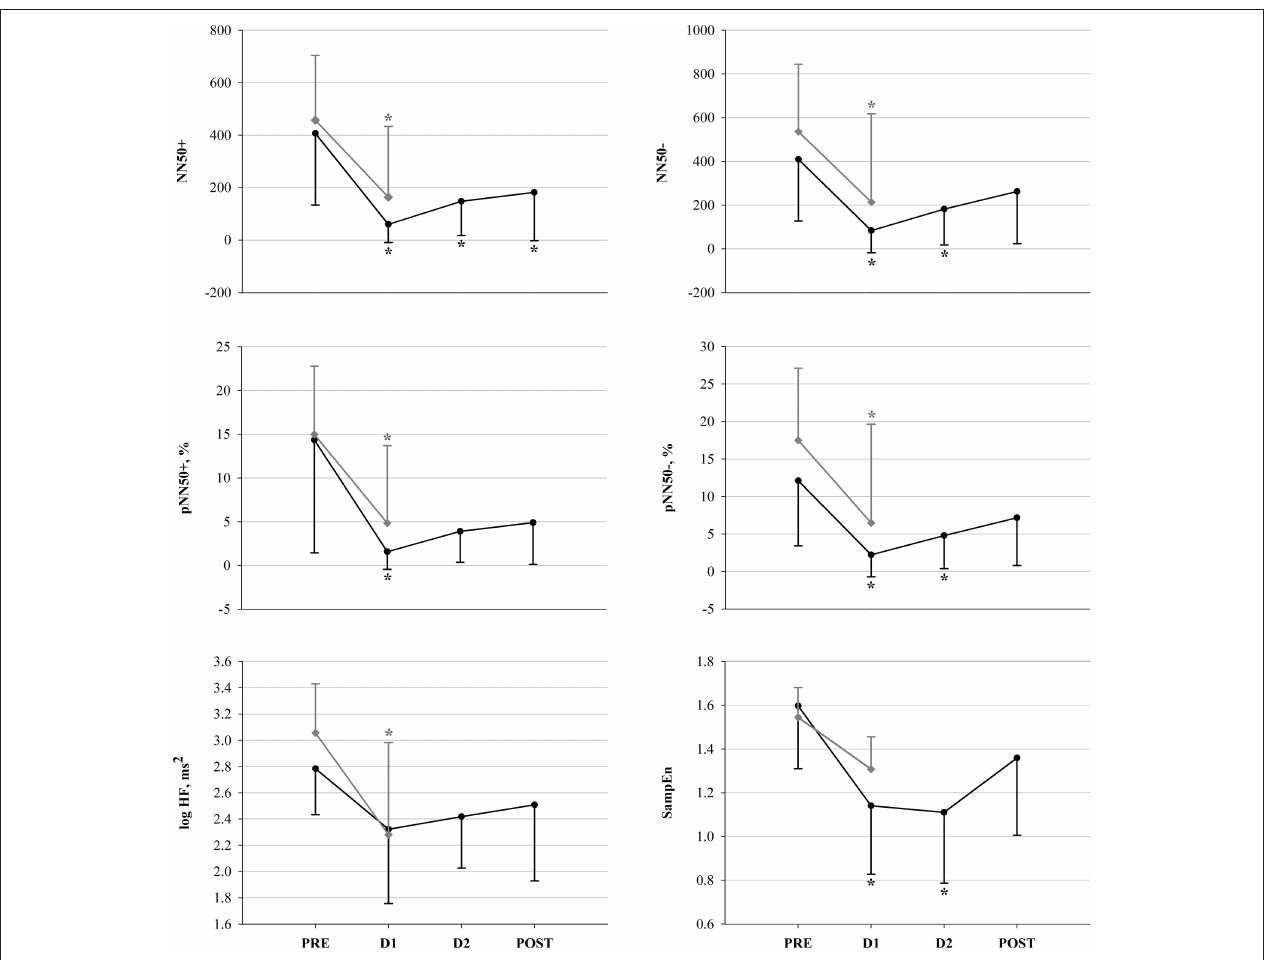
FIGURE 4 | Vagal modulation indices in FIN (black line) and in NON (gray line) across time-points. * p < 0.05 vs. PRE within subgroup (all variables: One-Way RM ANOVA; pNN50 + : Friedman